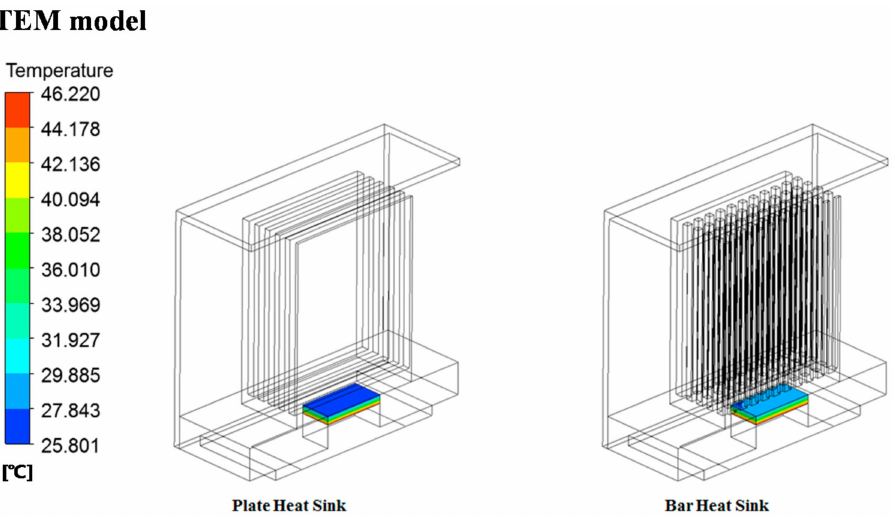
Figure 6. Numerical analysis results of temperature gradient of the thermoelectric module (TEM) with plate and bar type cooling